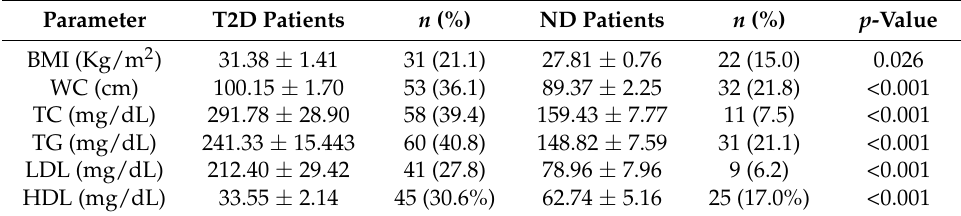
Table 2. Comparison of obesity and lipid abnormalities in patients.